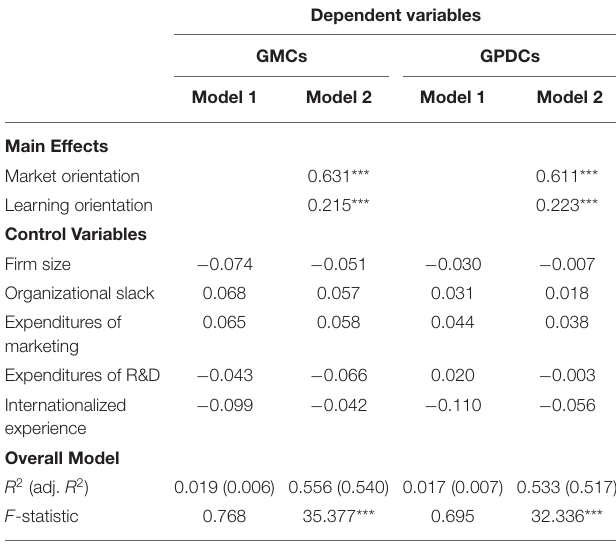
TABLE 4 | Tests for the impact of capability-building support activity on global dynamic